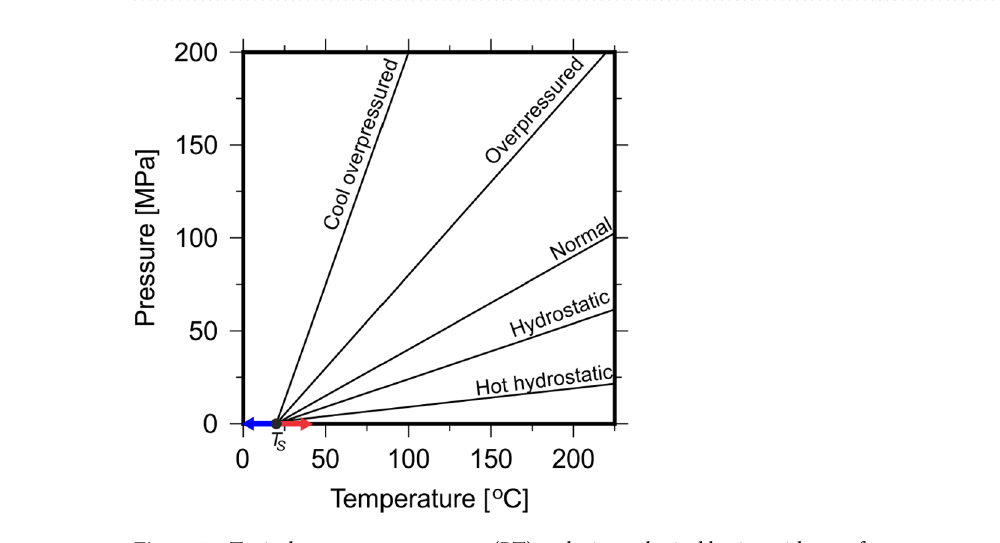
Figure 5. Typical pressure temperature (PT) paths in geological basins with a surface temperature of 20 ◦ C 7 . PT gradients are as follows: cool and overpressured = 2.5 MPa/K, overpressured = 1.0 MPa/K, normal = 0.5 MPa/K, hydrostatic = 0.3 MPa/K and hot hydrostatic = 0.1